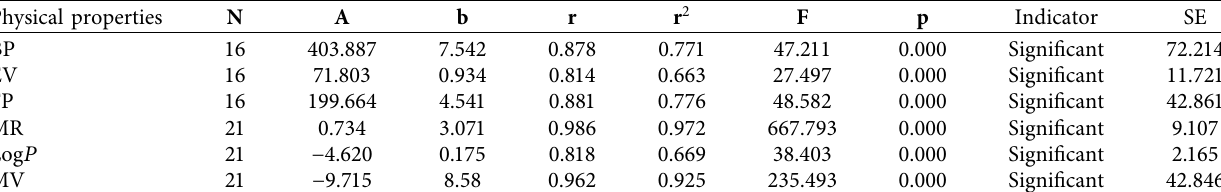
Table 11: Statistical specifications for the linear model of SS ( G ) .